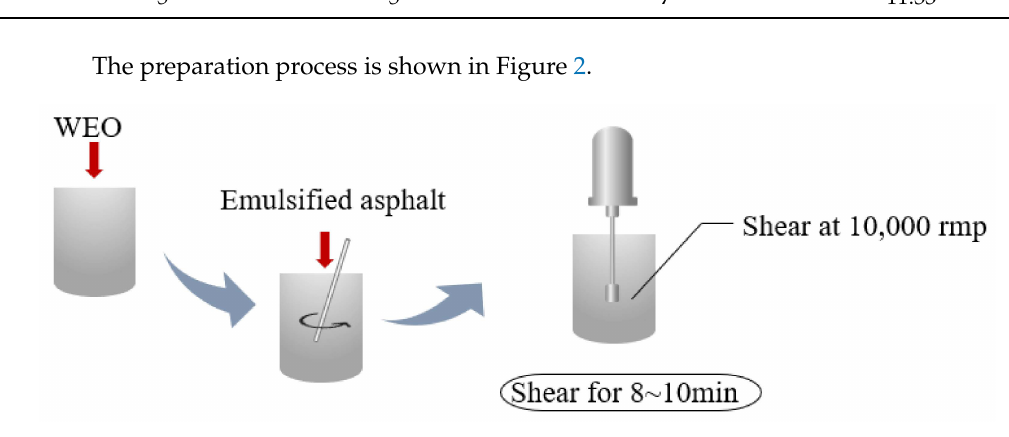
Figure 2. Preparation process of WEREA modified by oxidized extraction